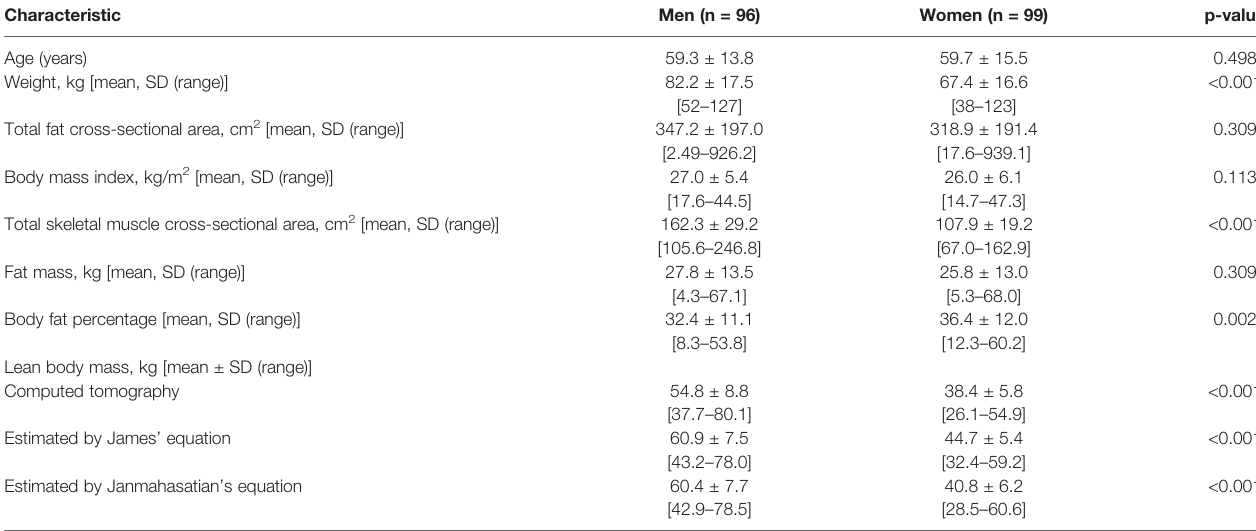
TABLE 1 | Patient characteristics.